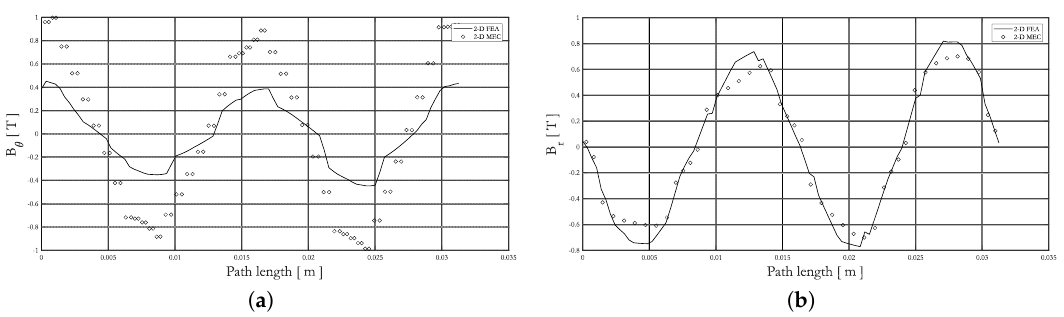
Figure 11. Waveform of B in the rotor PMs: ( a ) tangential, and ( b ) radial component.